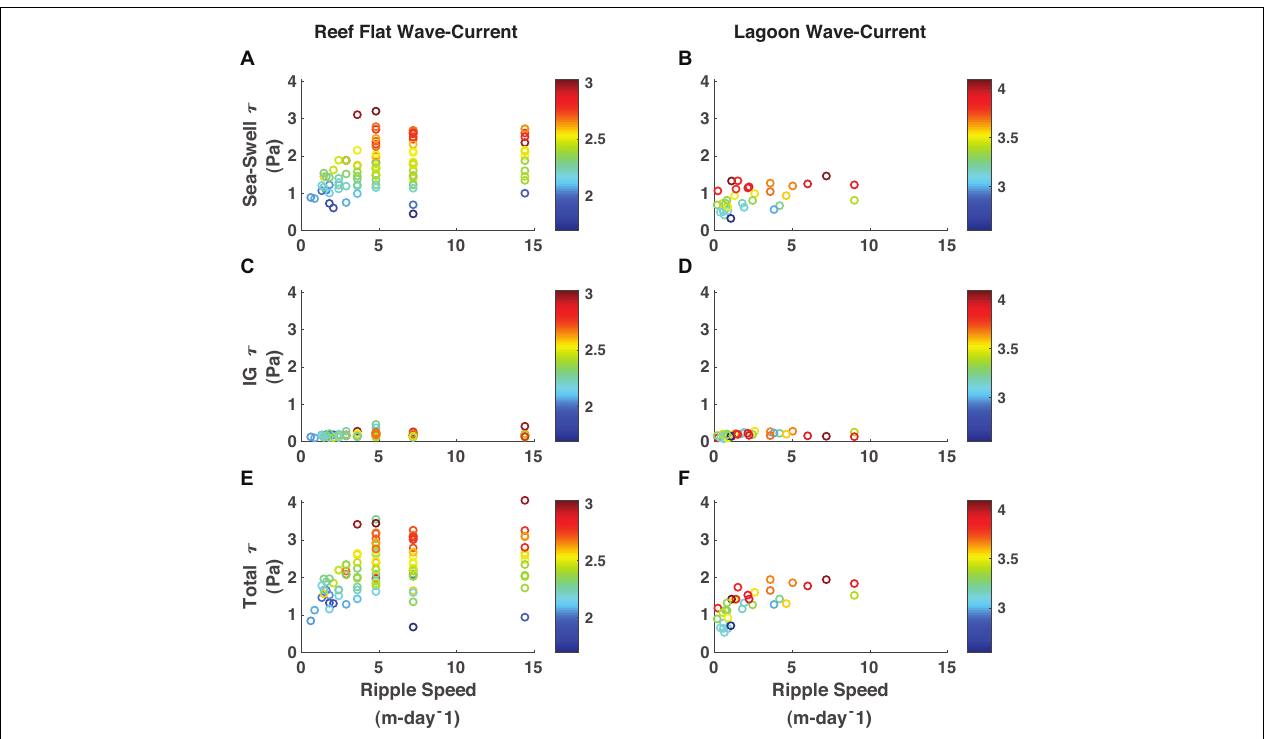
FIGURE 8 | Shear stress ( τ ) versus ripple speed as a function of water level. (A) τ due to sea-swell waves at TR2 on the inner reef flat. (B) τ due to sea-swell waves at TR3 in the lagoon. (C) τ due to infragravity waves at TR2 on the inner reef flat. (D) τ due to infragravity waves at TR3 in the lagoon. (E) Total τ at TR2 on the inner reef flat. (F) Total τ at TR3 in the lagoon. Color denotes the total water level, in